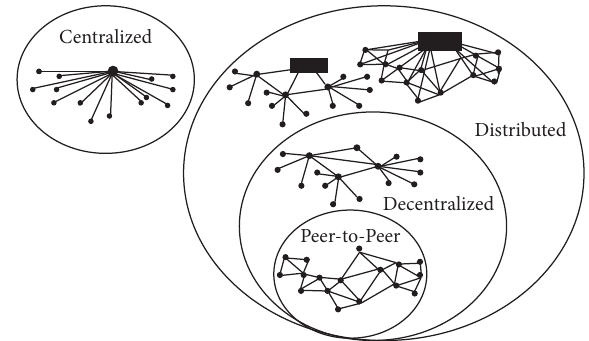
Figure 19: Schematic diagram of three communication